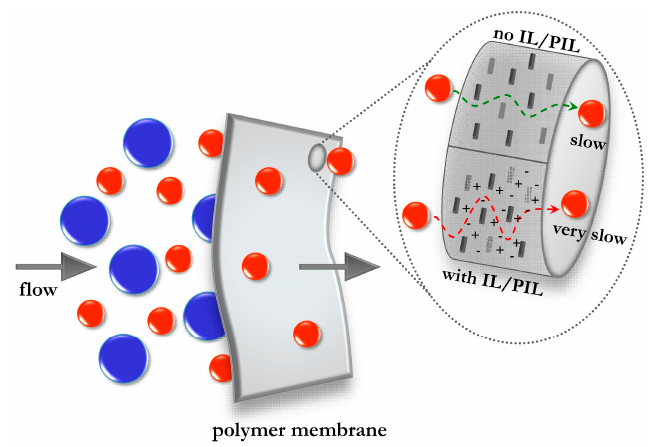
Figure 9. Schematic representation of the liquid/gas permeation through a polymer membrane. A slow flow is caused by the filler/polymer via tortuous path, where the addition of IL/PIL cause an even slower/more selective permeation due to their multiple-interaction features.